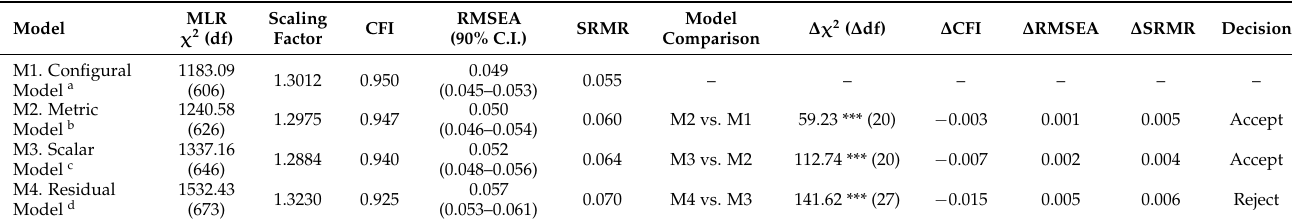
Table 2. Model fit statistics for tests of measurement invariance.